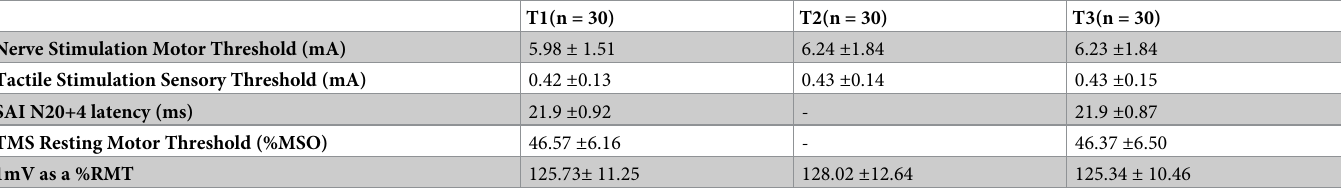
Table 1. Group averaged measures (with standard deviations). SAI acquired with an ISI of N20+4ms, evoked by median nerve